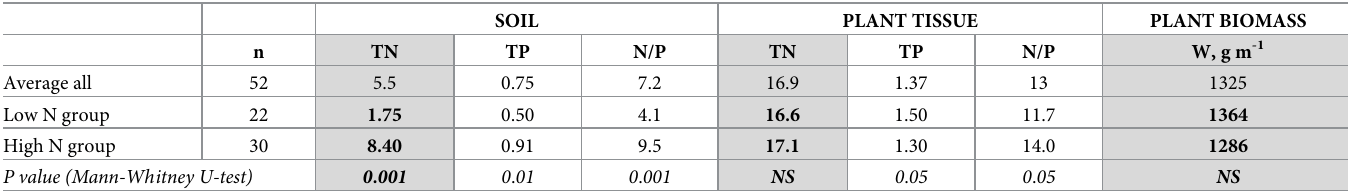
Table 1. Soil and plant total nitrogen, TN, and phosphorus, TP, mg g -1 , and aboveground biomass, W, from 52 populations of Schoenoplectus californicus [23]. SOIL PLANT TISSUE PLANT